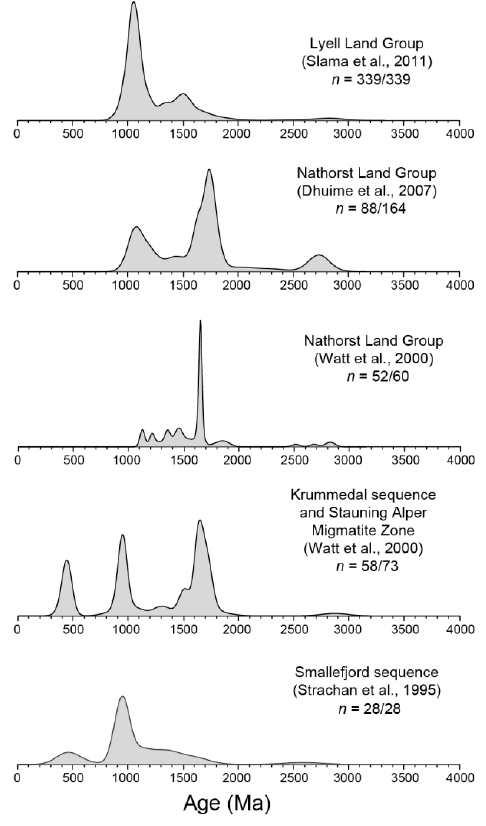
Figure 3. Kernel density estimation (KDE) plots of published zircon U–Pb ages from metasedimentary rocks in the Caledonides of East Greenland. The abundance of younger Proterozoic ages (c. 1000 – 1900 Ma) is more variable. A diverse spectrum of Proterozoic ages coupled with a scarcity of > 1900 Ma ages (e.g., sample L1102) is consistent with the metasedimentary rocks of the Nathorst Land Group [15] (Figure 3). A peak at c. 950 Ma in samples M6006 and M6007 may reflect metasedi- mentary rocks affected by early Neoproterozoic crustal anatexis, similar to that recog- nised in the Krummedal sequence and Stauning Alper Migmatite Zone [13], and in the Smallefjord sequence [12]. The samples are located some distance from these regions, suggesting that crustal anatexis was relatively widespread. Sample M6006 has a uniquely prominent age peak of c. 1100 Ma and an age spectrum that is strikingly similar to that of